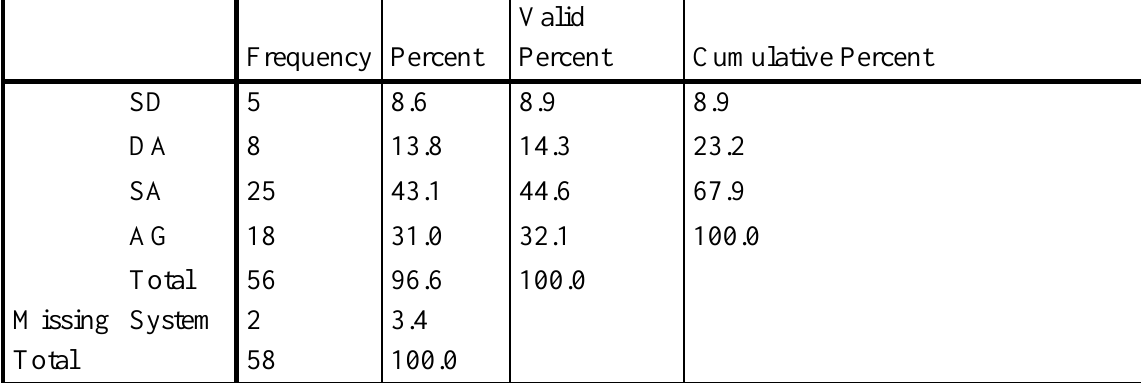
My Teacher plays very little role in making English an Essay subject for